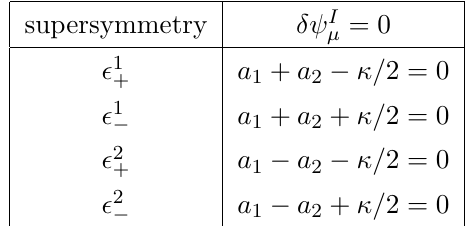
Table 4 . Supersymmetry equations for N = 2 theories. The supersymmetries in the left column are preserved when the twisting parameters a i satisfy the corresponding equations in the column on the